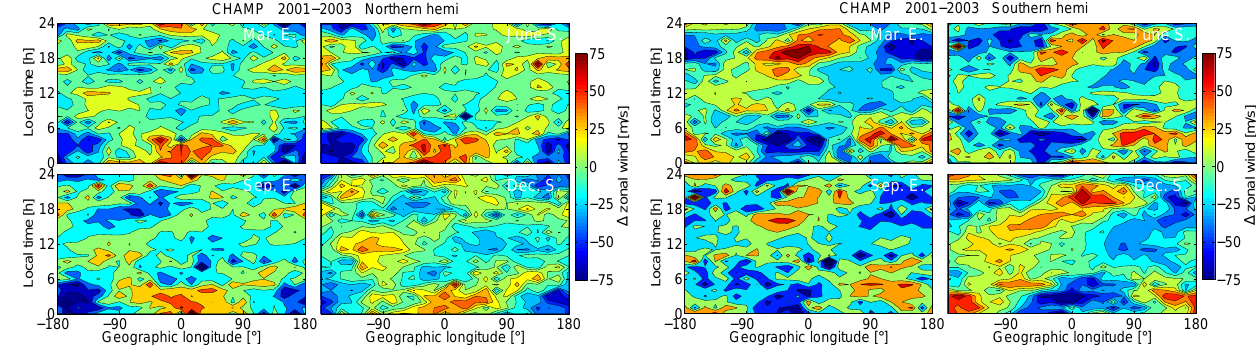
Figure 3. Local time versus longitudinal distribution of zonal wind for four seasons in the Northern (left) and Southern (right) hemispheres from CHAMP measurements.